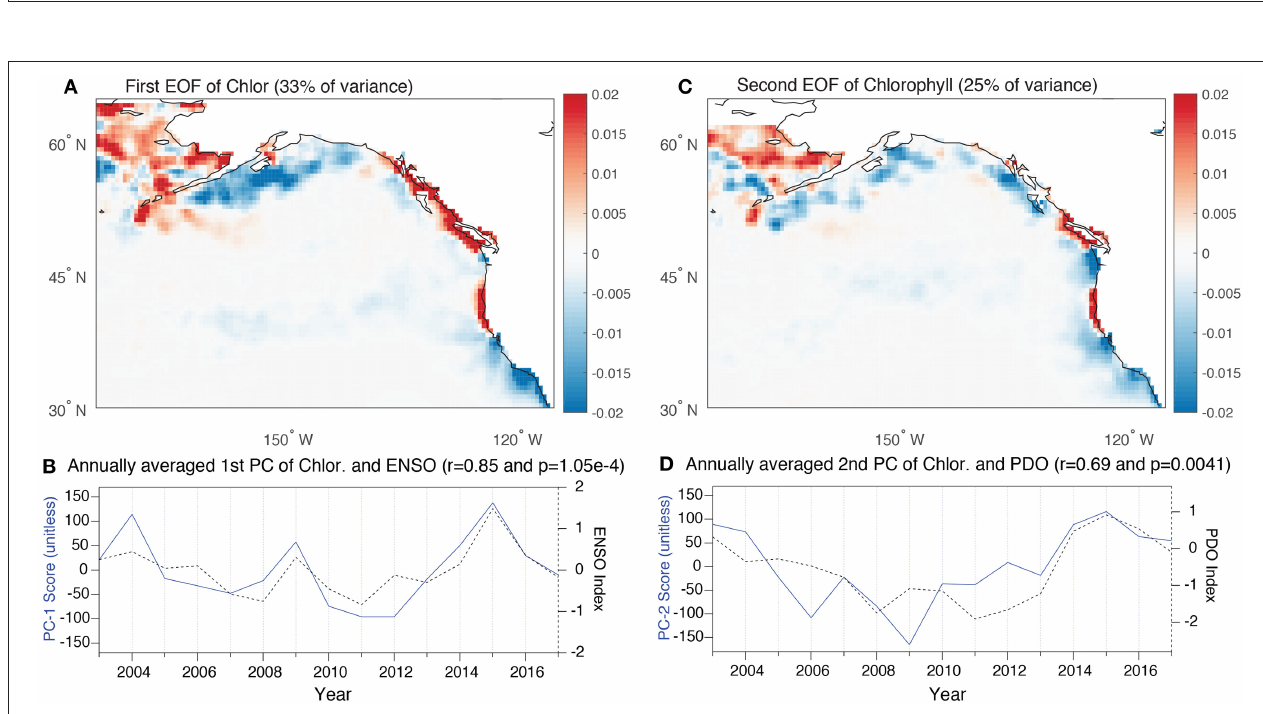
FIGURE 4 | (A,C) The first and second EOF of chlorophyll for the region of interest. The units are dimensionless loadings with explained variances of 33 and 25%, respectively. (B,D) The first and second annually averaged vectors of the PCs associated with the EOFs shown in above panels. The first PC is plotted alongside the annually-averaged ENSO index ( r = 0.89) and the second PC is plotted alongside PDO as in Figure 2 ( r = 0.69).